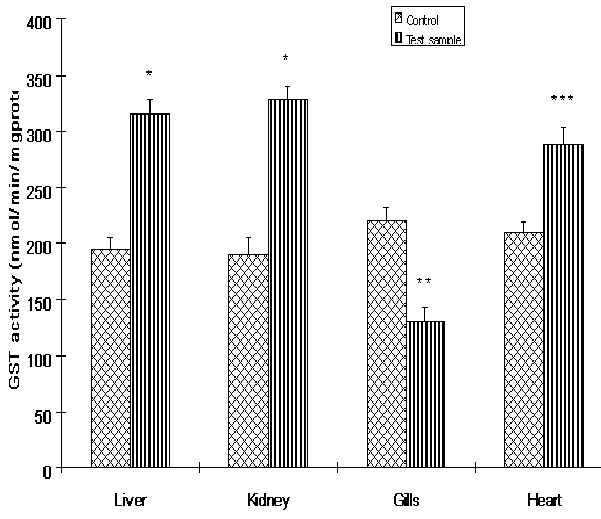
Figure 3 : The activities of Glutathione S-transferase (GST) in the livers, kidney, Gills and heart of Clarias gariepinus from the Ogun River and Agodi farm. Values are mean ± SD of 10 fishes. Significantly different from control,* p<0.001;** p<0.01; ***p<0.05